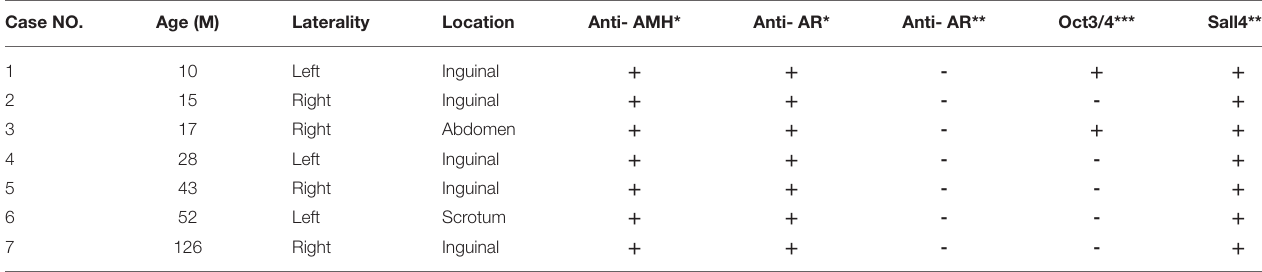
TABLE 3 | The immunohistochemical findings of vanishing testis specimens with GCs. Case